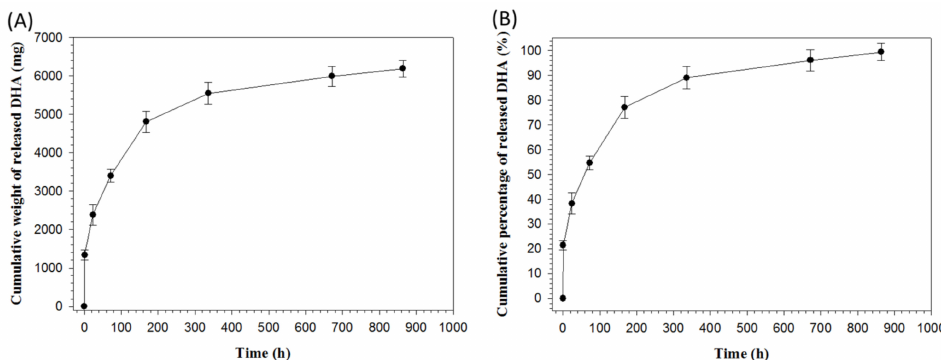
Figure 5. The release profiles of docosahexaenoic acid (DHA) from polylactic acid / docosahexaenoic acid (PLA / DHA) core-shell nanofiber membrane determined from the cumulative released weight ( A ) and cumulative released percentage (normalized to loaded DHA in the membrane) ( B ) of